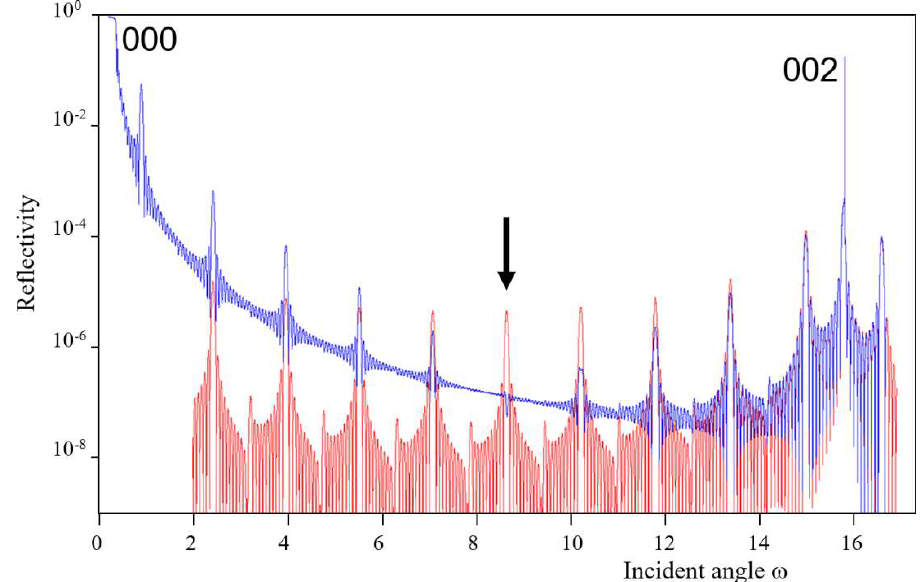
Figure 1. Two dynamical theory calculations; (red) the 2-beam theory calculations using 2-tie points of the dispersion surface for the 002 reflection and (blue) the 2-beam theory using 4-tie points for the 002 and 000 reflection on a superlattice sample {AlAs (2.861 nm) + GaAs (2.86 nm)} × 50 on GaAs. The most used theory (red) deviates significantly beyond a few degrees from the 002 Bragg peak. This is especially notable at the arrow mark, where the superlattice peaks in the more complete theory are absent but present in the simpler theory. The incident angle ω is the angle to the sample surface, which in this case is also the angle to the crystal planes Ω.